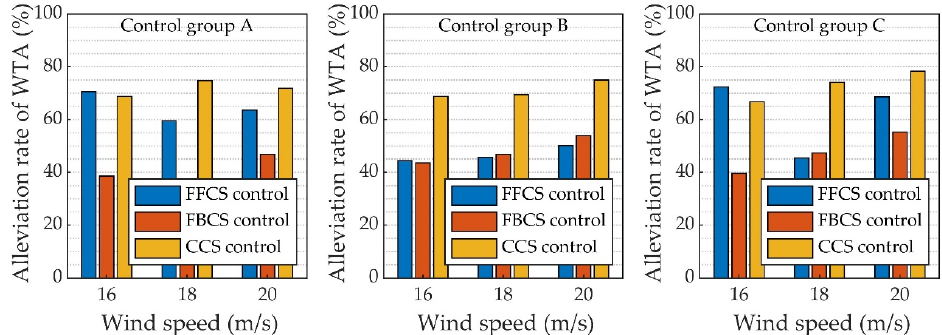
Figure 16. Comparison of WTA alleviation rate in wind tunnel test.